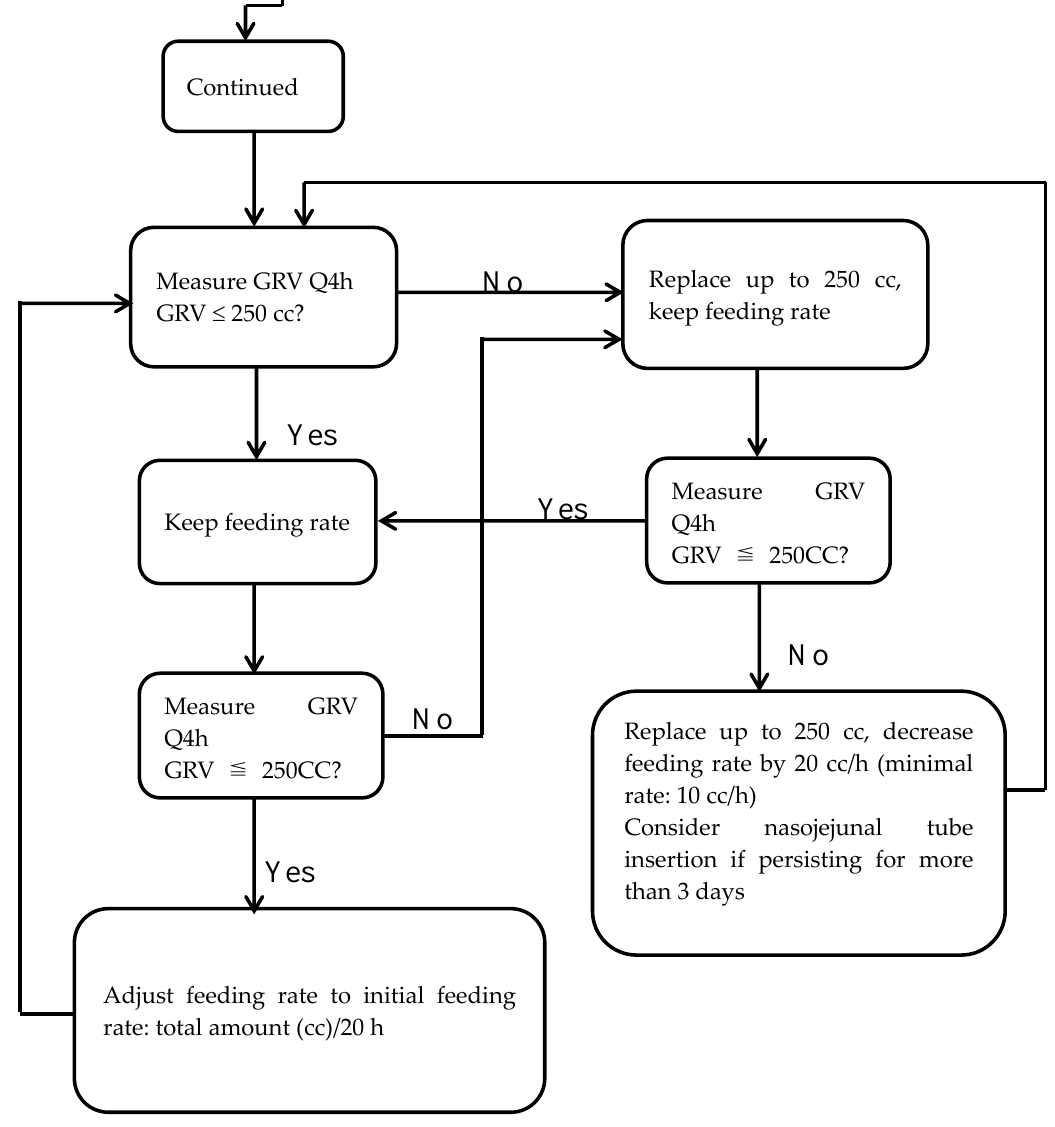
Figure 1. Volume-based feeding protocol flow chart. GRV, gastric residual volume, NPO, nil per os.